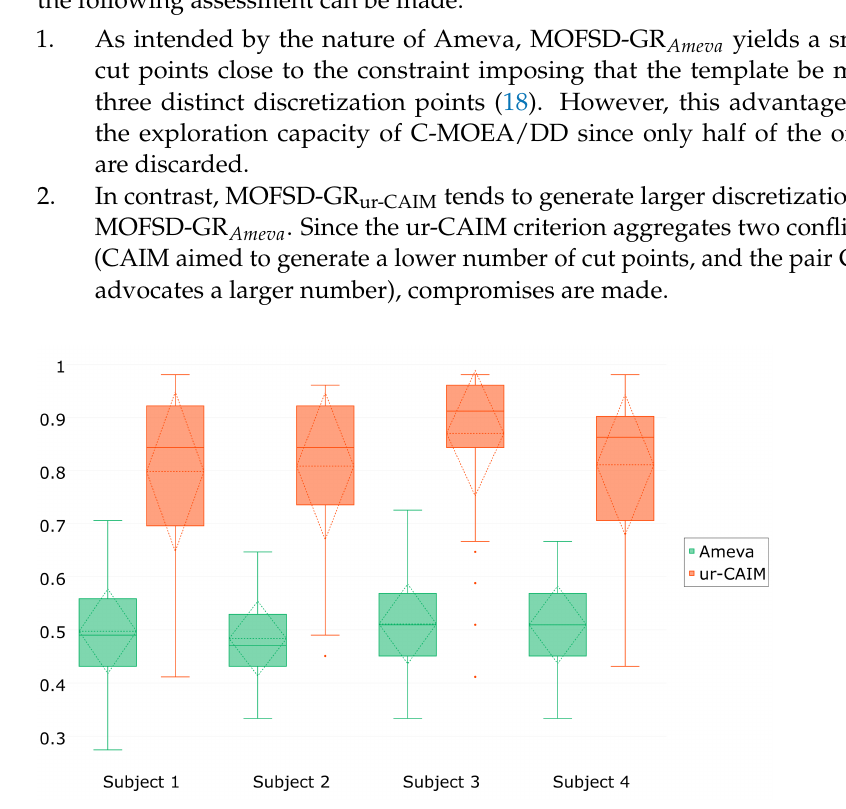
Figure 3. Box plot representation for feature selection (reduction rate in %).